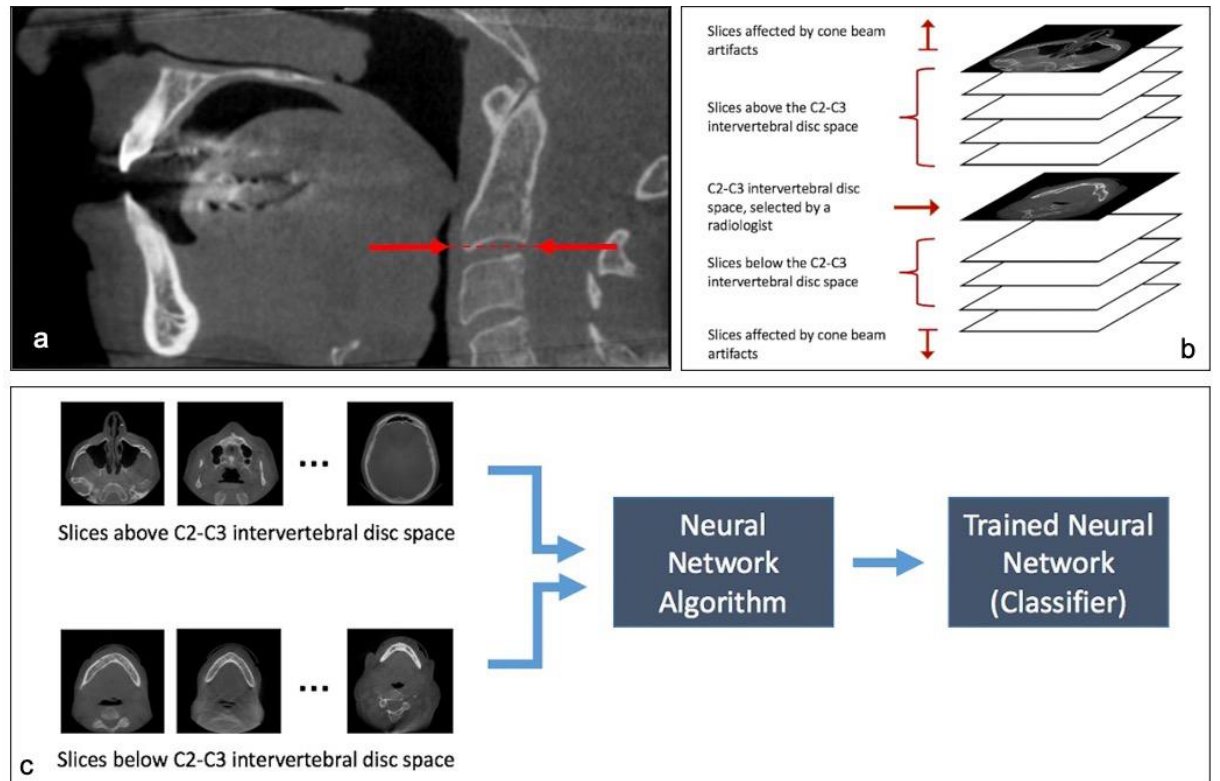
Figure 1. ( a ) . The radiologist recorded the midpoint of C2–C3 intervertebral disc in the mid-sagittal view and recorded the axial slice number of this boundary, if any. ( b ). Classification of axial slices into cone beam artifacts and slices above and below the C2–C3 intervertebral disc space. ( c ). Process of training the Classifier neural network with the two groups of data created by the radiologist.